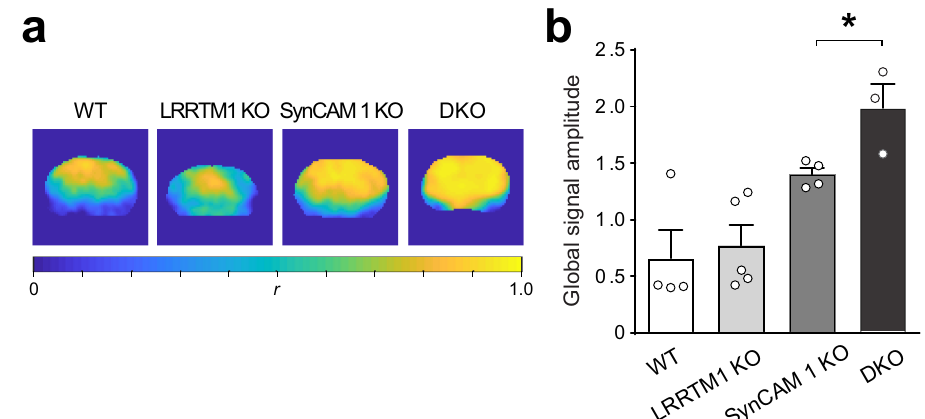
Fig.5|AlteredsynchronizationofbrainactivityinLRRTM1andSynCAM1DKO mice. a Maps of the Pearson ’ s correlation coef fi cient r between the fMRI global signal (GS) and all voxels in the whole brains of representative mice from each group.Onecoronalslice,~ − 4mmBregma,isshownpermouse.CorrelationwithGS is stronger in SynCAM 1 KO and DKO groups. b SynCAM 1 and LRRTM1 together modulatespontaneous,synchronousbrainactivitypatternsasshownbymeasuring